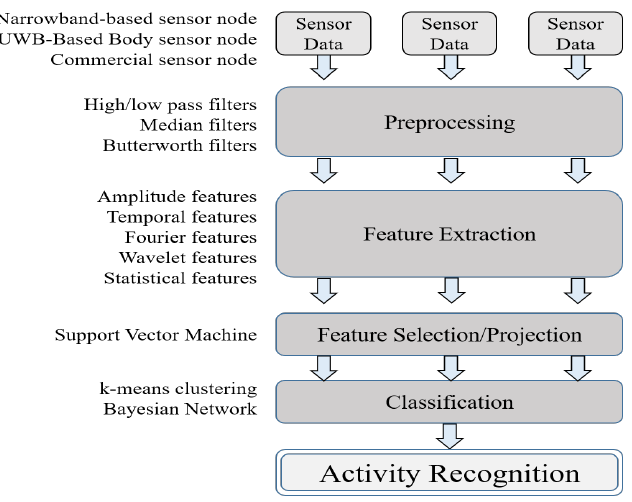
Figure 3. Typical activity recognition process for inferring activities from WBAN